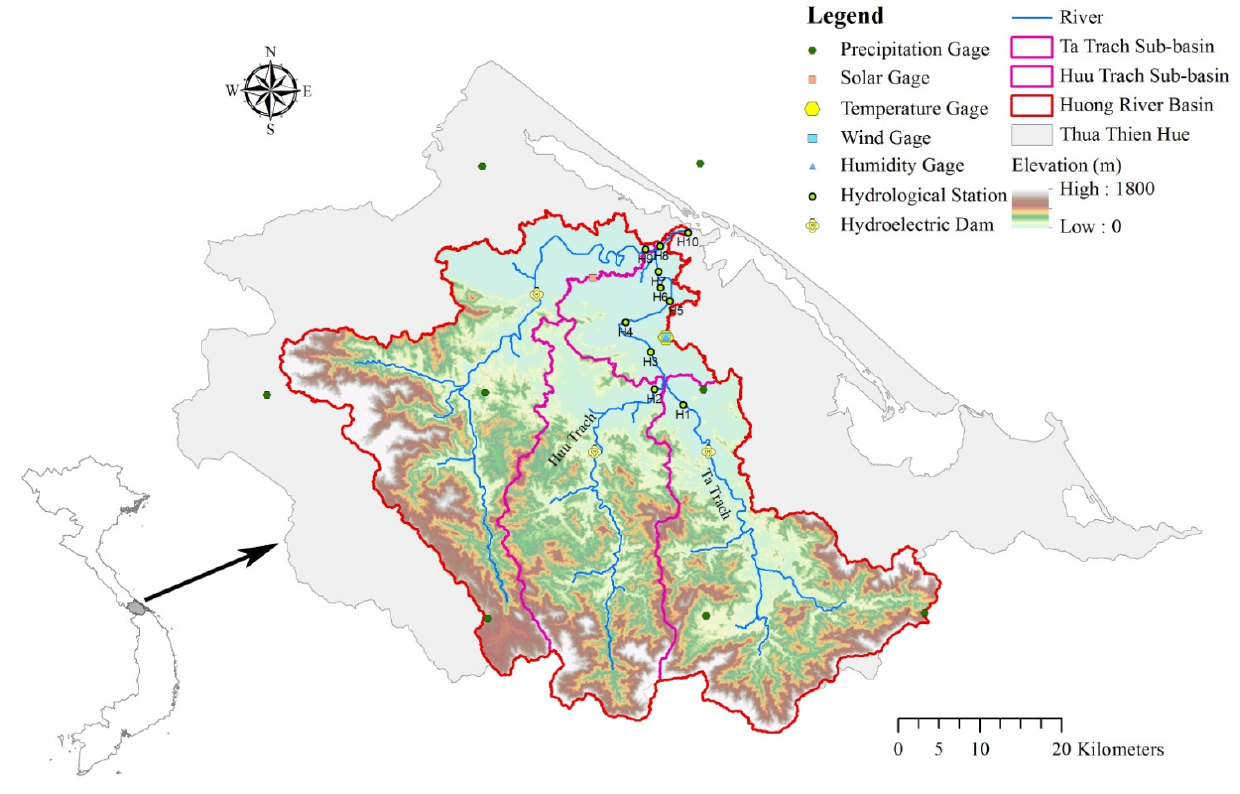
Figure 1. The Huong River basin in Central Vietnam [28]. Following SWAT